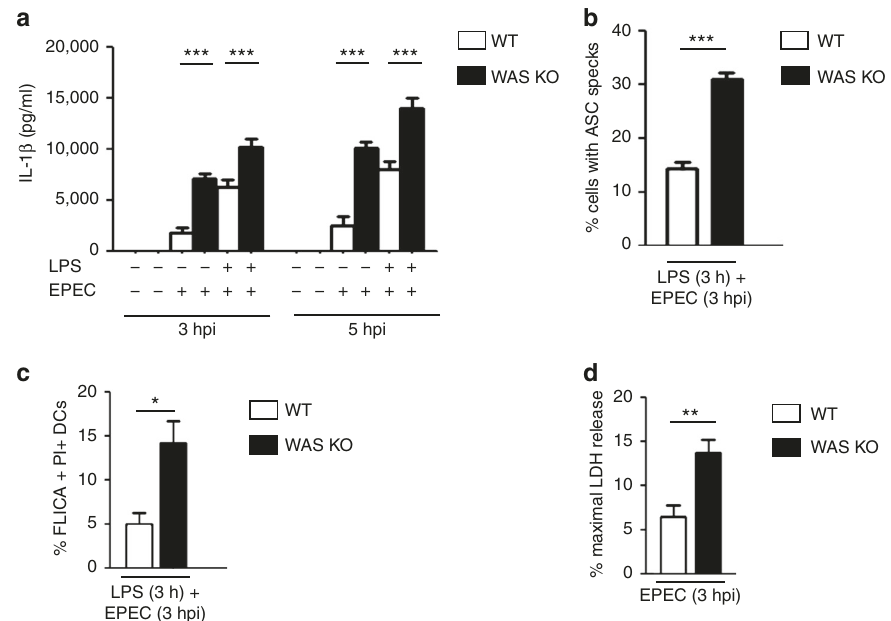
Fig. 2 Enteropathogenic E. coli -mediated in fl ammasome activation. a WT or WAS KO BMDCs were co-cultured with WT E2348/69 EPEC strain at an MOI of 5 for 3 or 5 h. After co-culture, cells were treated with 100 µ g/ml gentamicin for 2 h to kill extracellular bacteria (total 5 or 7 hpi). In parallel experiments, BMDCs were primed with LPS (100 ng/ml) for 3 h prior to infection. After infection, IL-1 β protein levels were quanti fi ed in culture supernatants by ELISA. Results are mean protein concentration ± SEM of three independent experiments in duplicate. Two-sided Student ’ s t -test. b WT or WAS KO BMDCs were primed with LPS (100 ng/ml) for 3 h prior to co-culture with WT EPEC (MOI of 5) for 3 h. After fi xation, cells were stained for bacteria (DAPI (4 ′ ,6- diamidino-2-phenylindole)), ASC (green) and actin phalloidin (red). Images were taken by confocal microscopy (×40 magni fi cation) and the percentage of BMDCs containing ASC specks were quanti fi ed. Results are represented as mean ± SEM from three independent experiments. A minimum of 200 BMDCs were evaluated per quanti fi cation. Two-sided Student ’ s t -test. Representative confocal images are shown in Supplementary Fig. 2A. c WT or WAS KO BMDCs were primed with LPS (100 ng/ml) for 3 h, followed by co-culture with WT EPEC (MOI of 5) for 3 h. Intracellular active caspase-1 was detected by FAM-YVAD-FMK (FAM-FLICA) binding, dead cells were stained with PI. The percentage of FLICA and PI double-positive BMDCs were enumerated by fl ow cytometry (FLICA collected in FL-1 gate; PI collected in FL-2 gate). Results are mean ± SEM of three independent experiments. Two-sided Student ’ s t - test. A representative fl ow plot is shown in Supplementary Fig. 2B. d WT or WAS KO BMDCs were co-cultured with WT EPEC (MOI of 5). Three hours after infection, pyroptotic cell death was measured by LDH release, expressed as a percentage of maximum LDH release measured from control, uninfected cells. Results are mean ± SEM of three independent experiments. Two-sided Student ’ s t -test. * p < 0.05; ** p < 0.01; *** p <